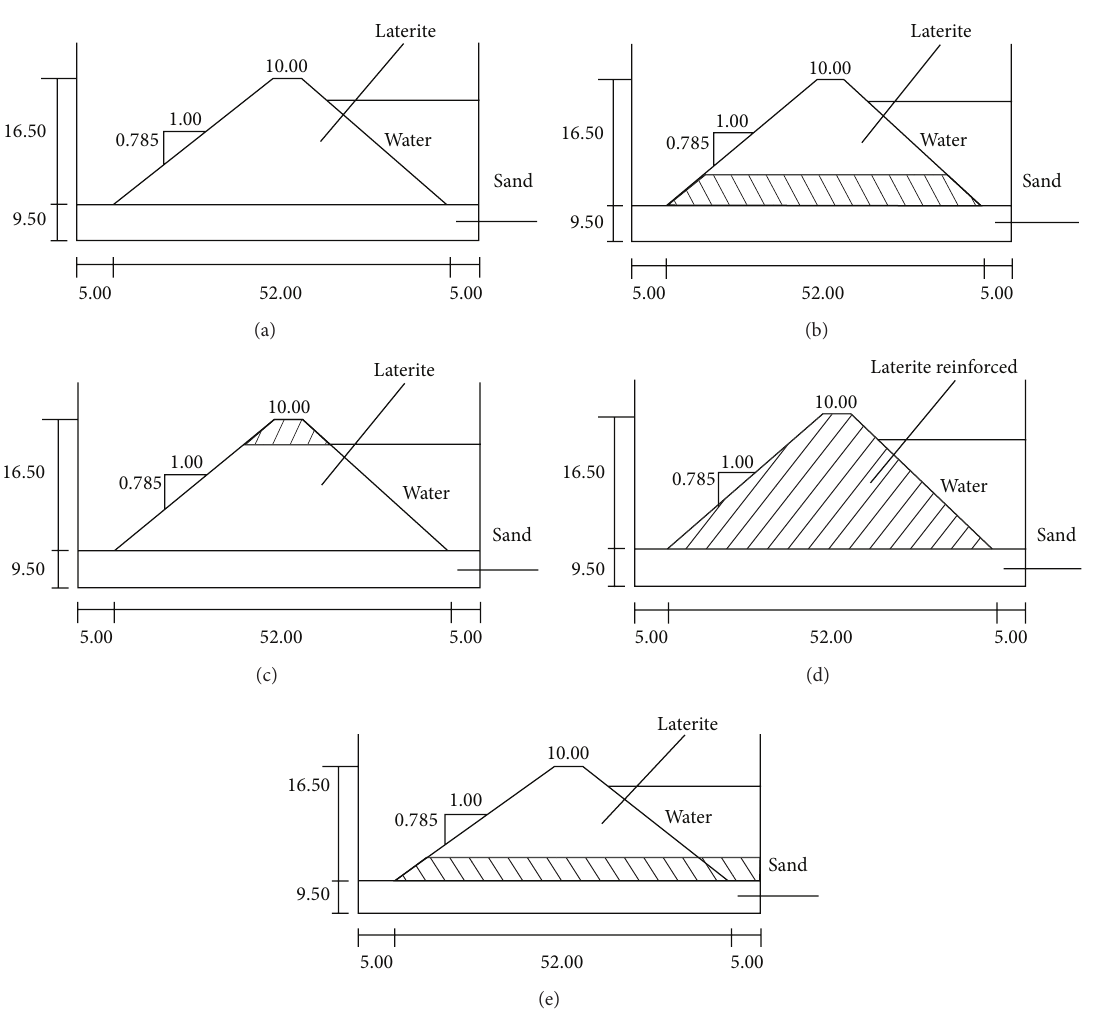
Figure 17: Model introducing ((a), (b), (c), (d) and (e)) for small dam (cm) ( 𝑆 = 1/100